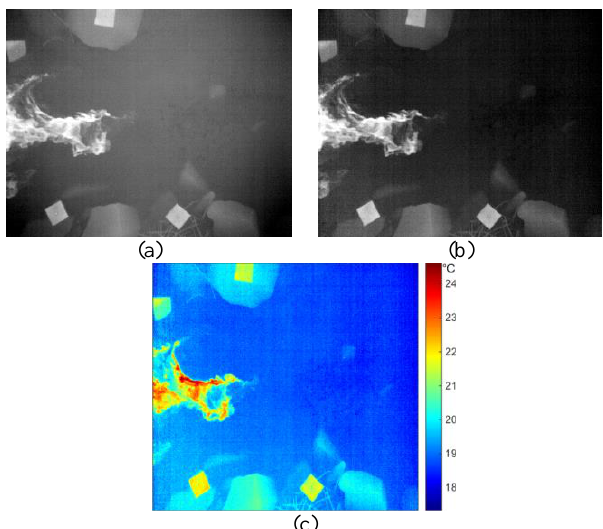
Figure 6. Radiometric Calibrated Results: (a) 31 st Original Image (b) NUC Corrected Image (c) Radiant Temperature Image